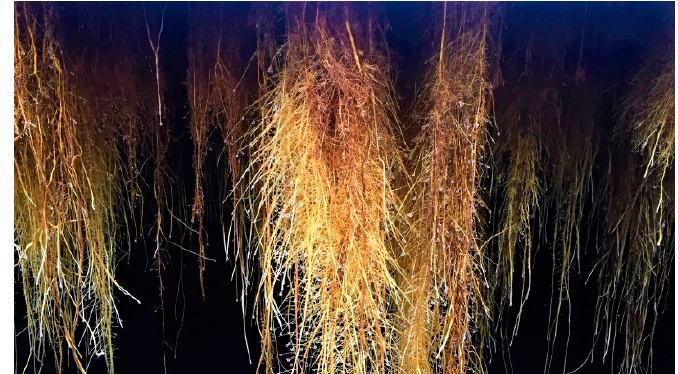
Figure 2. Close-up view of Morus. alba L. roots grown aeroponically.